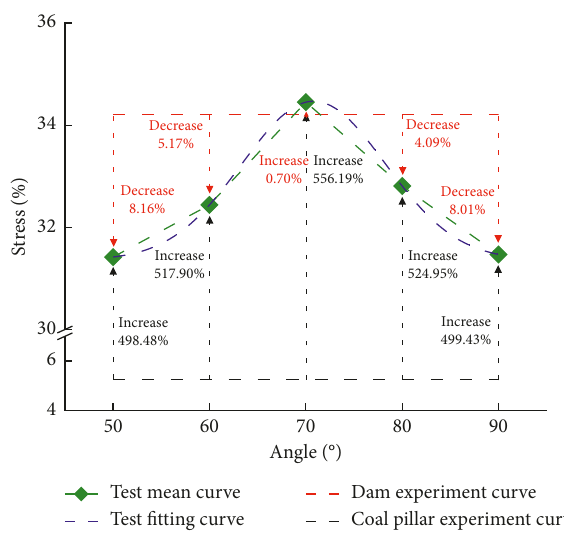
Figure 10: Relationship between angle and compressive strength.